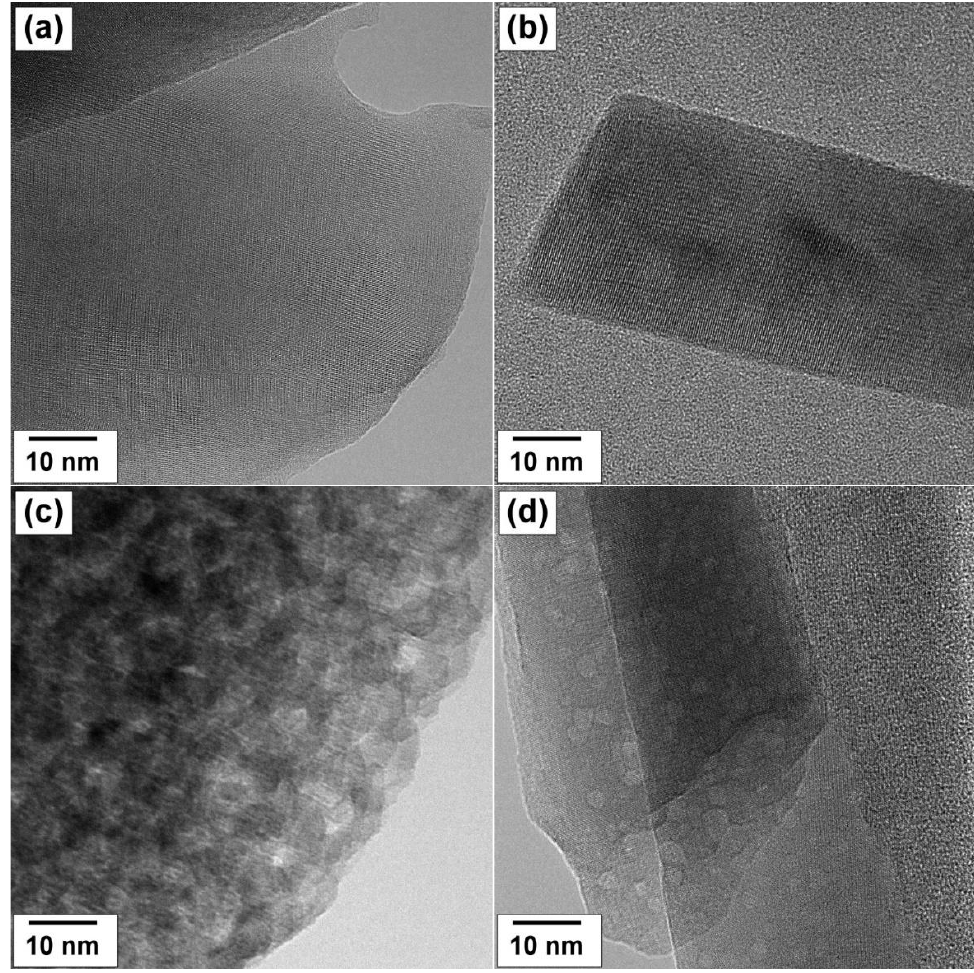
Figure 5. HR TEM images of 10%V/C12A7 sample: ( a , b ) mayenite particles; ( c ) alumina-rich particles; ( d ) calcium vanadate particle.